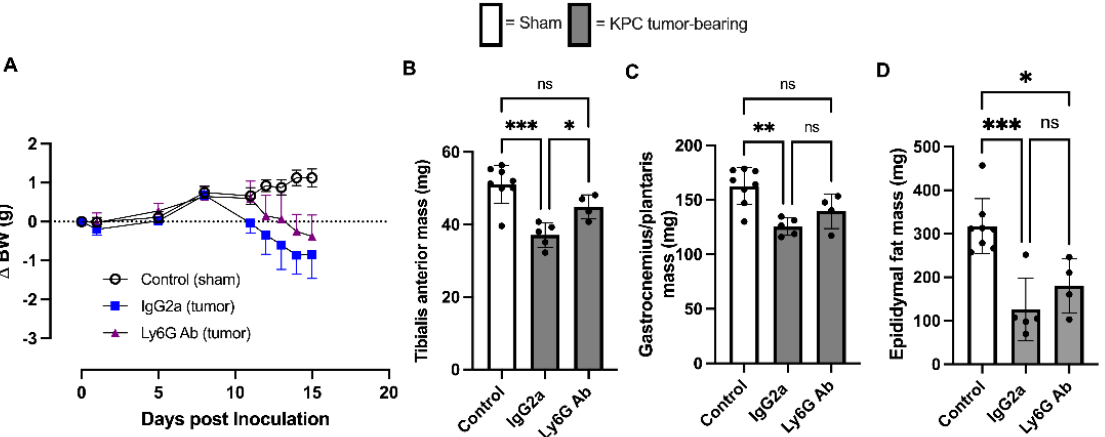
Figure 2. Effect of anti-Ly6G antibody on body weight and skeletal muscle mass in the orthotopic KPC model of cancer cachexia. ( A ) Changes in body weight (mean and standard deviation) of Sham mice (Control; n = 8) and KPC tumor-bearing groups treated with either isotype control (IgG2a; n = 5) or anti-Ly6G antibody ( n = 5) throughout study duration. ( B ) Tibialis anterior ( C ) and gastrocnemius/plantaris and ( D ) epididymal fat pad mass from control mice and KPC mice treated with isotype control or anti-Ly6G antibody at experimental endpoint. Open bars = control group; grey bars = tumor bearing. * p < 0.05; ** p < 0.01; *** p < 0.001; ns = not significant ( p > 0.05).